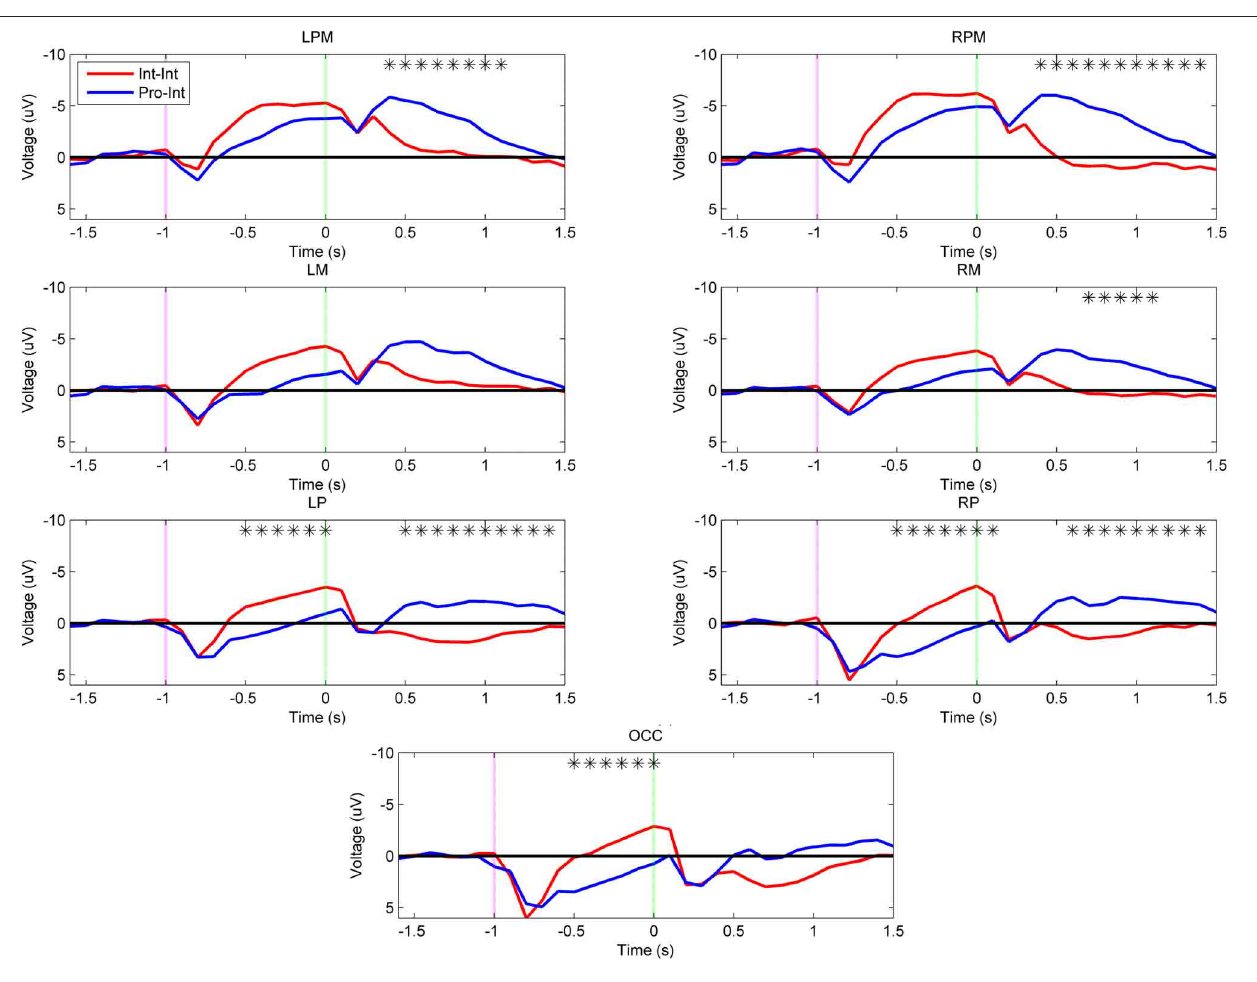
FIGURE 5 | Grand-averaged region-level voltage plots for the Int–Int (red) and Pro–Int (blue) groups. The planning cue is marked with a pink dotted line at –1.0s and the execution cue is marked